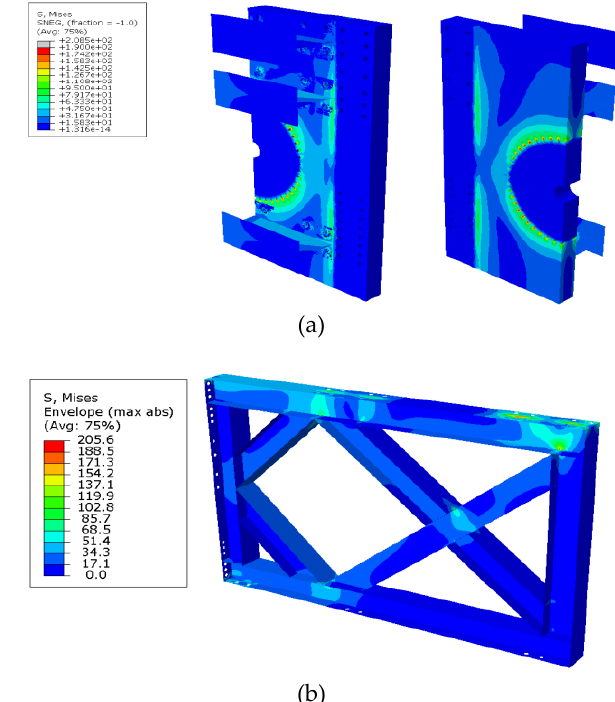
Fig.11. FE models of test frame components, (a) fixing plate, (b) side wall frame.